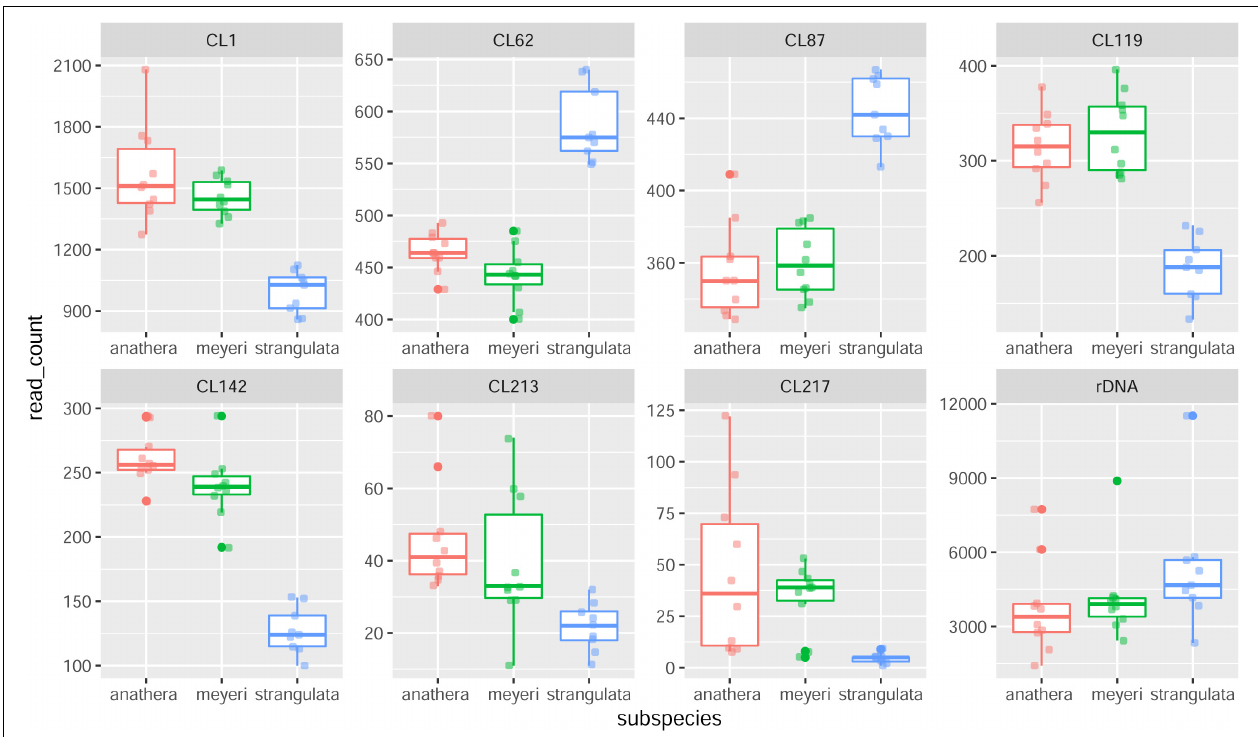
FIGURE 1 | Box plot of repetitive DNA abundances (number of reads in each read sample) in 29 Ae. tauschii accessions belonging to subsp. anathera (red dots), subsp. meyeri (green dots) and subsp. strangulata (blue dots). CL119, CL1, CL142, CL87, and CL62 clusters showed significant differences between subspecies and CL213 and rDNA (45S) showed considerable variation between